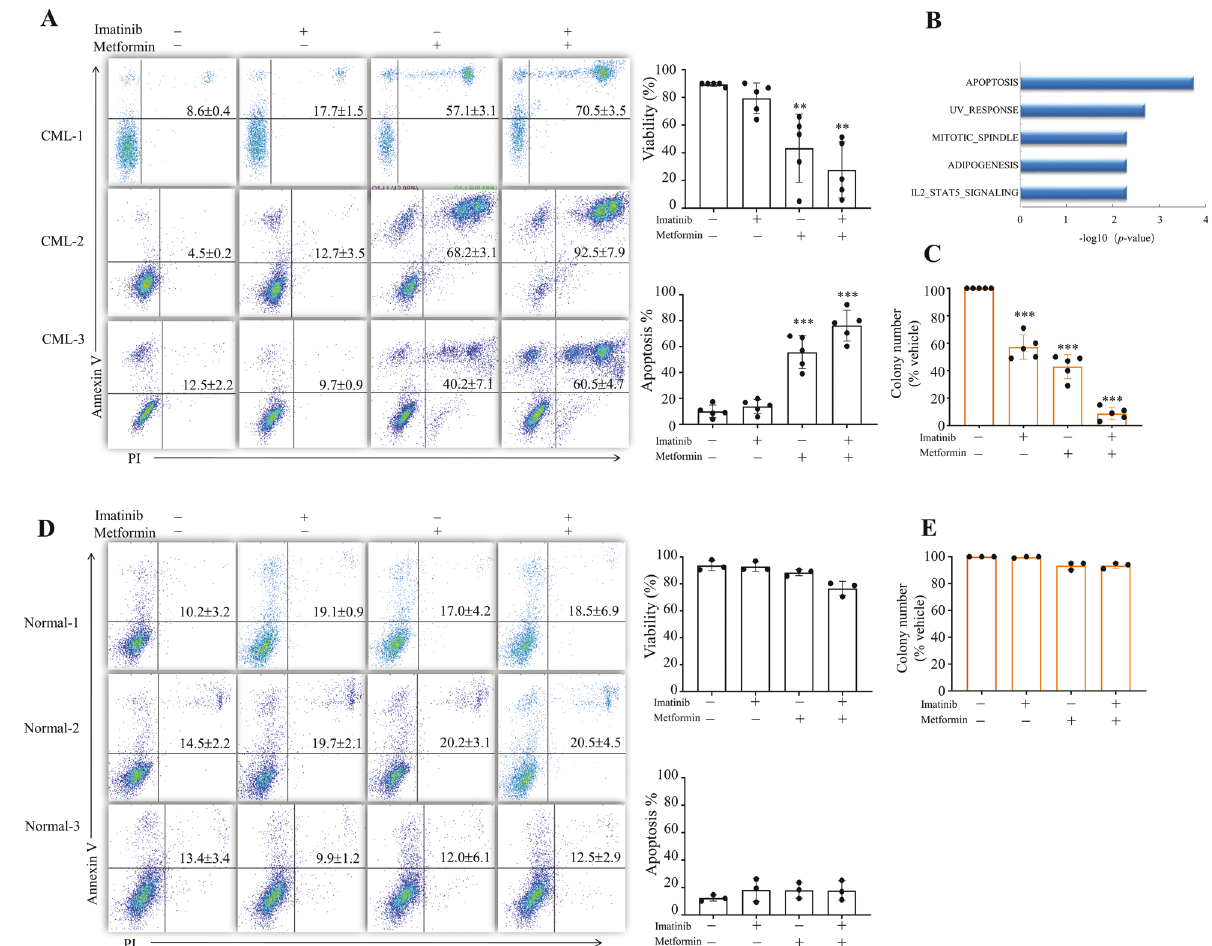
Fig. 3 Metformin induces apoptosis of cultured CD34 + CML cells. A Puri fi ed CD34 + cells from CML patients were treated with metformin, imatinib or metformin plus imatinib for 72 h. Cell apoptosis were measured by Annexin V/PI staining. Representative fl ow cytometry plots of CD34 + cells from three CML individuals were shown. Cell viability measured by trypan blue ( n = 5 patient samples) and quanti fi ed apoptosis ( n = 5 patient samples) were shown on the right. B Puri fi ed CD34 + cells from CML patients were treated with metformin for 24 h and subjected to label-free quantitative MS analysis. Top fi ve signi fi cant enrichment pathways after metformin treatment are shown. The differentially expressed proteins were used to carry out the analysis under the threshold of FC > 1.5 and P < 0.05. C CFCs of CD34 + CML cells from patients treated with metformin, imatinib or metformin plus imatinib for 48 h. Colony numbers were shown. n = 5 patient samples. ** and *** indicated P value against 0 or control group <0.005 and <0.001, respectively. D , E Puri fi ed CD34 + cells from normal donors were treated with